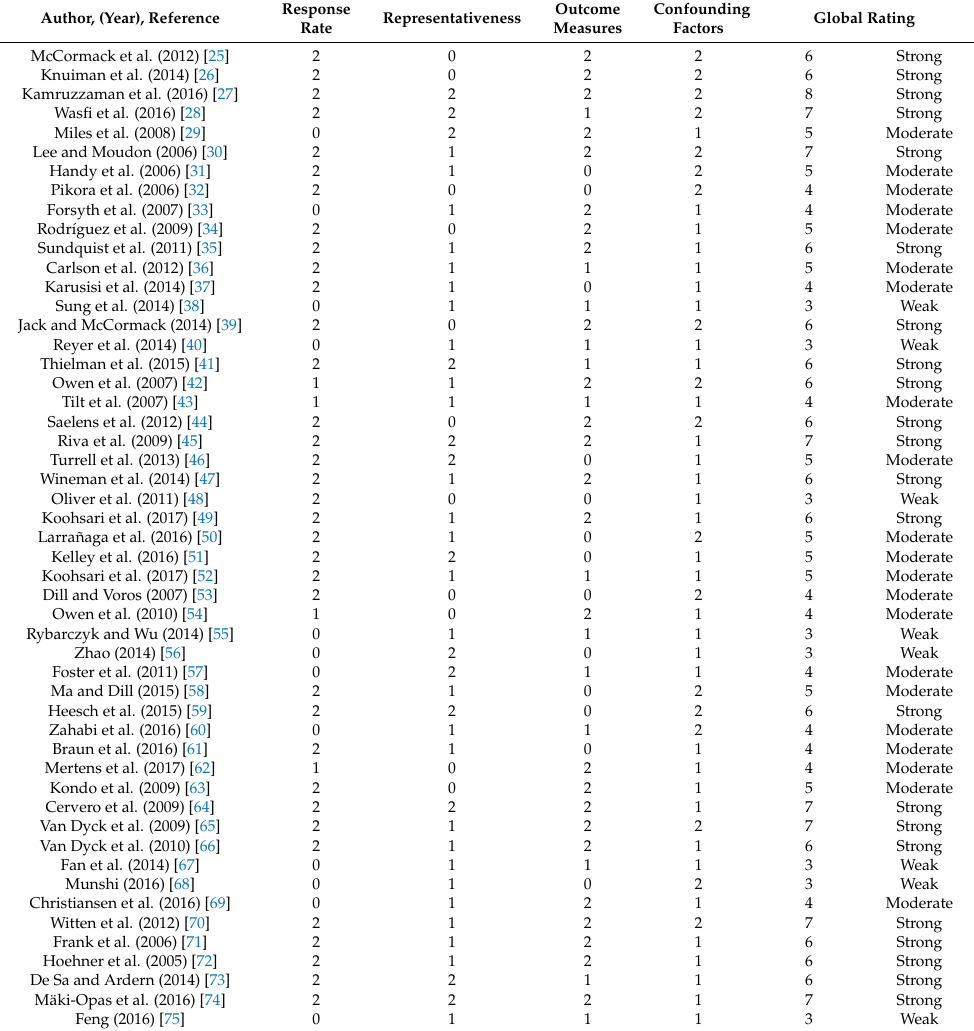
Table 5. Summary of quality assessment